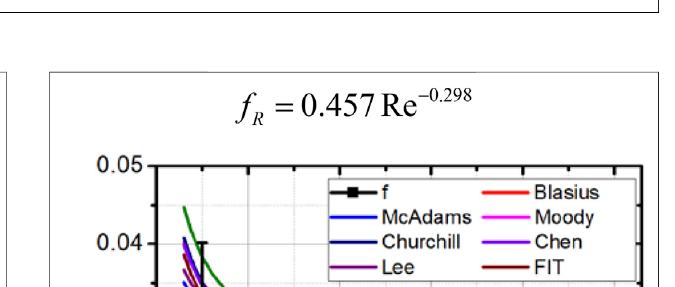
FIGURE 3 | Axial pressure loss of three impulse pipes.